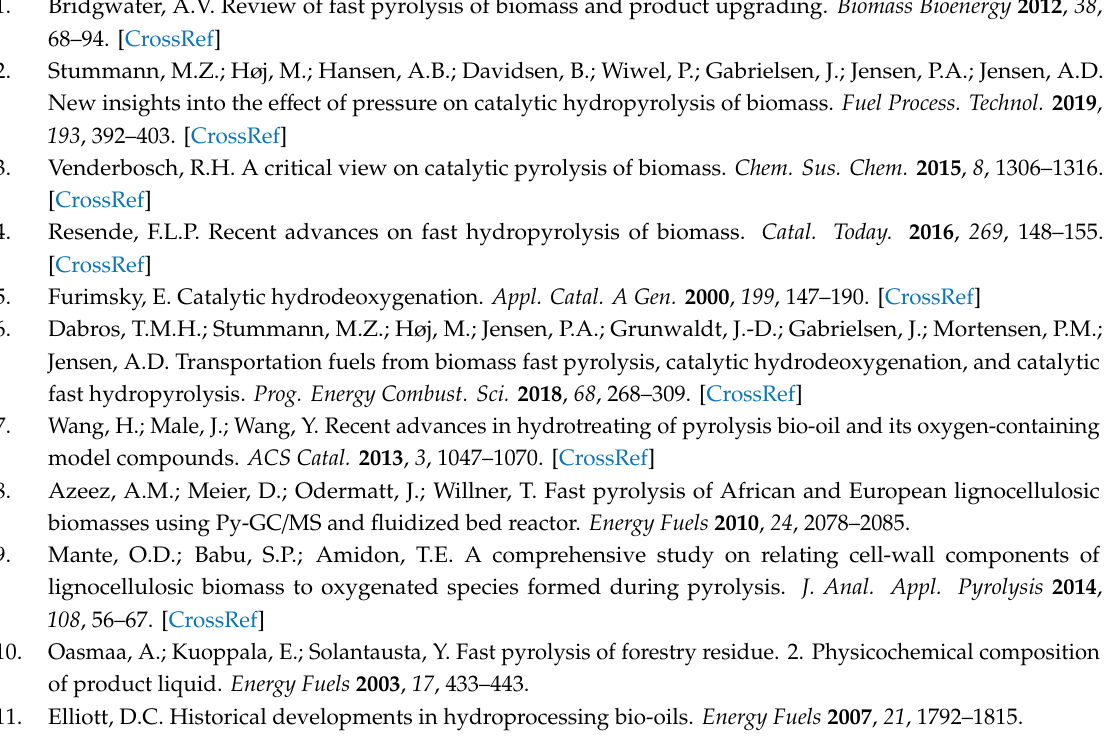
Figure S1 : Simplified process diagram of the continuous flow fixed bed reactor setup. P: pump. MFC: Mass flow controller. PIC: Pressure indicator and controller. S1: Separator. dP: Di ff erential pressure cell. C1: Condenser. V1-V8: Magnetic valves, Figure S2 : Schematic drawing of reactor design including pressure shell, internal reactor, and thermo pocket. The gas and liquid inlets are shown. The insert to the right shows the gas and liquid feed flow paths at the internal reactor tube inlet, Figure S3: Initial temperature profiles. In the experiment with acetic acid (AcOH), the acetic acid feed was stopped at TOS ≈ 2.2 h, Figure S4 : E ff ectiveness factor estimated for the fastest reaction in the conversion of ethylene glycol (dashed line) and cyclohexanol (solid line) as a function of catalyst particle radius. The actual particle radius used in HDO activity tests (150–300 µ m) is shaded, Figure S5 : Arrhenius plots for the rate constants presented in the main manuscript (Table 1). (a) k (cid:48) 1a : Initial dehydration and hydrogenation of C 2,ox intro ethylene. (b) k (cid:48) 2a : Hydrogenation of ethylene into ethane, Figure S6 : Equilibrium composition during cyclohexanol HDO calculated with HSC Chemistry v. 9.4.1.Feed composition: 2.1